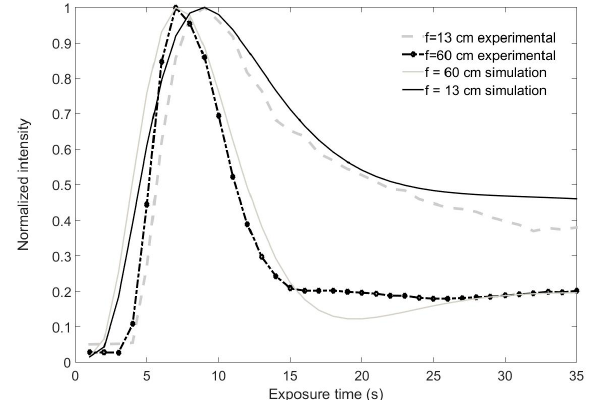
Figure 4. Normalized intensity at the focal point for two different focal lengths of 13 cm and 60 cm. Experimental data and simulations are represented.